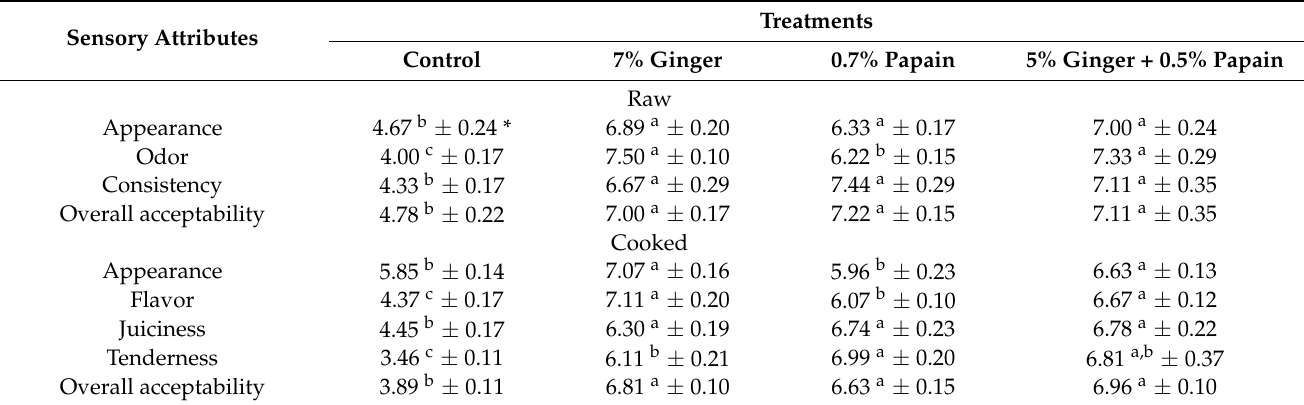
Table 2. Sensory scores of camel semitendinosus muscle after treatment with ginger extract